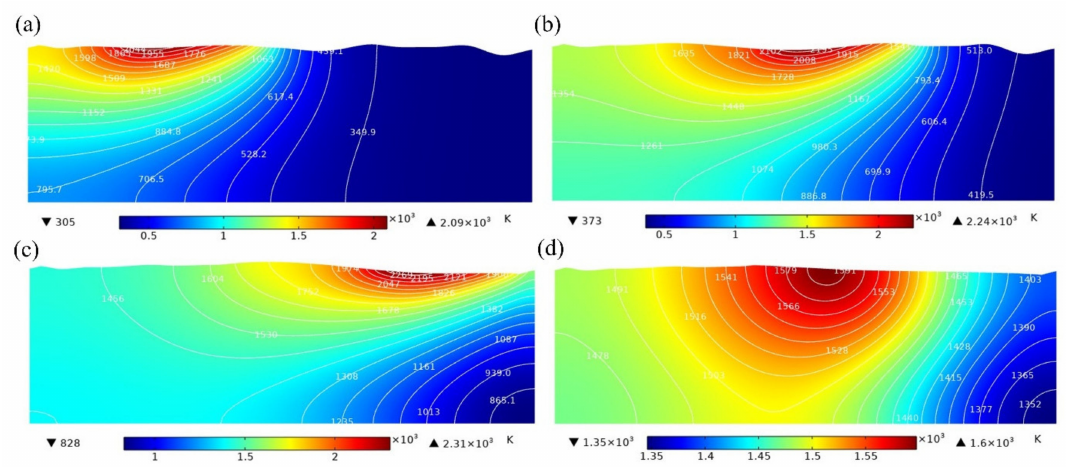
Figure 13. The temperature distribution of molten pool with MF = 0.3 T at ( a ) t = 5 ms, ( b ) t = 10 ms, ( c ) t = 15 ms, and ( d ) t = 20